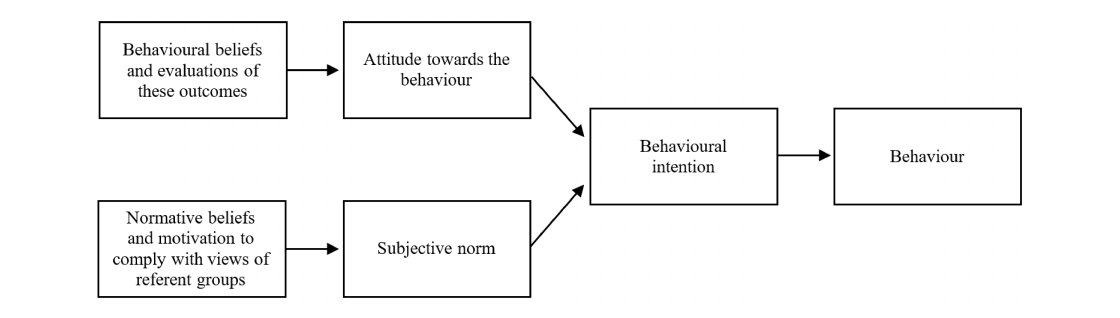
Figure 1. The theory of reasoned action (Source: Authors,